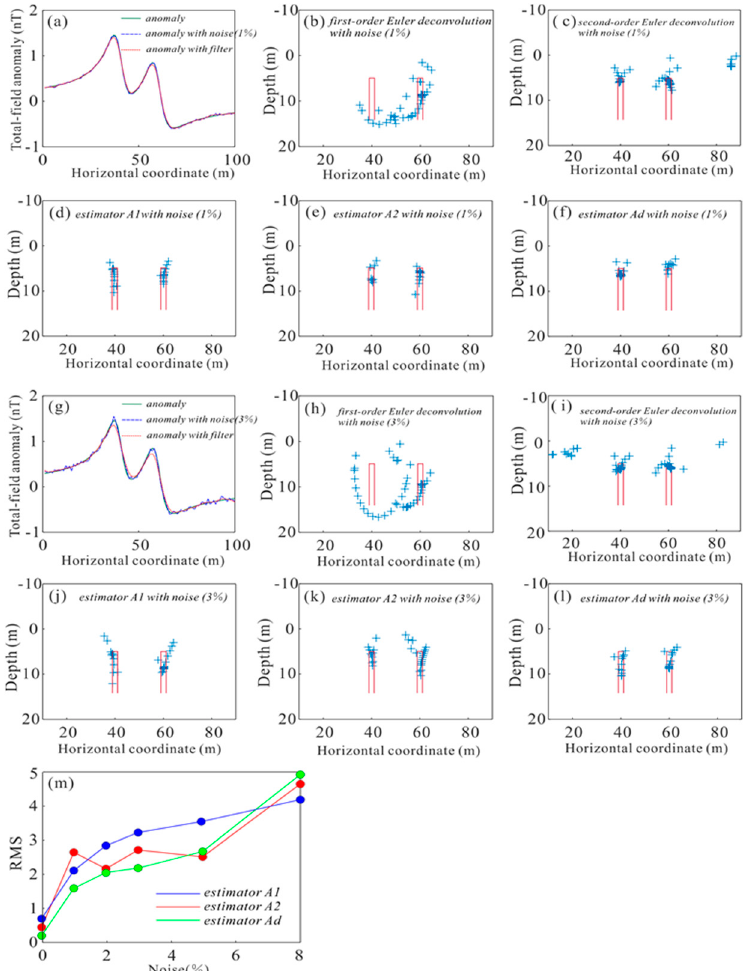
Figure 5. ( a ) Total magnetic anomaly of two infinite vertical sheets having a magnetic inclination of 60° and a declination perpendicular to strike, a noise-corrupted magnetic anomaly with a Gaussian noise of 1 ％ and a noise-corrupted magnetic anomaly with a subsequent Gaussian filter; ( b ) source location results generated by first-order Euler deconvolution method after filtering; ( c ) source location results generated by second-order Euler deconvolution method after filtering; ( d ) source location results generated by estimator A1 after filtering; ( e ) source location results generated by estimator A2 after filtering; ( f ) source location results generated by estimator Ad after filtering; ( g ) total magnetic anomaly of two infinite vertical sheets having a magnetic inclination of 60° and a declination perpendicular to strike, noise-corrupted magnetic anomaly with a Gaussian noise of 3 ％ and noise-corrupted magnetic anomaly with a subsequent Gaussian filter; ( h ) source location results generated by Euler deconvolution method after filtering; ( i ) source location results generated by Euler deconvolution method after filtering; ( j ) source location results generated by estimator A1 after filtering; ( k ) source location results generated by estimator A2 after filtering; ( l ) source location results generated by estimator Ad after filtering; ( m ) RMS between the true depths and average of all the depths computed by estimators A1, A2 and Ad with decreasing noise.